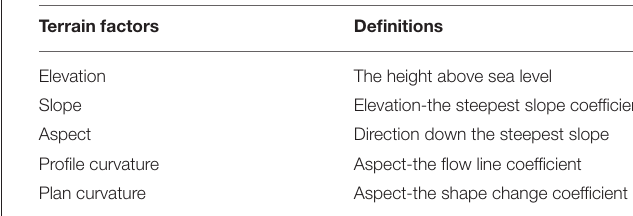
TABLE 1 | Terrain factor